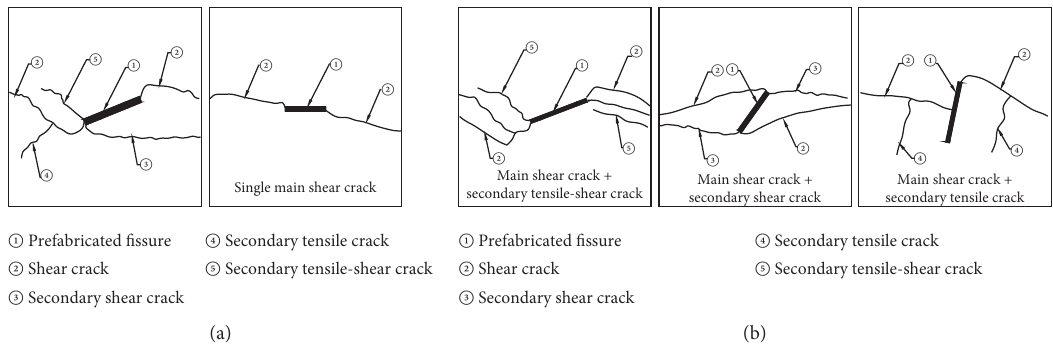
Figure 7: Schematic of crack types and propagation modes. (a) Crack type. (b) Crack propagation mode. Note: ① prefabricated fissure; ② shear crack; ③ secondary shear crack; ④ secondary tensile crack; ⑤ secondary tensile-shear